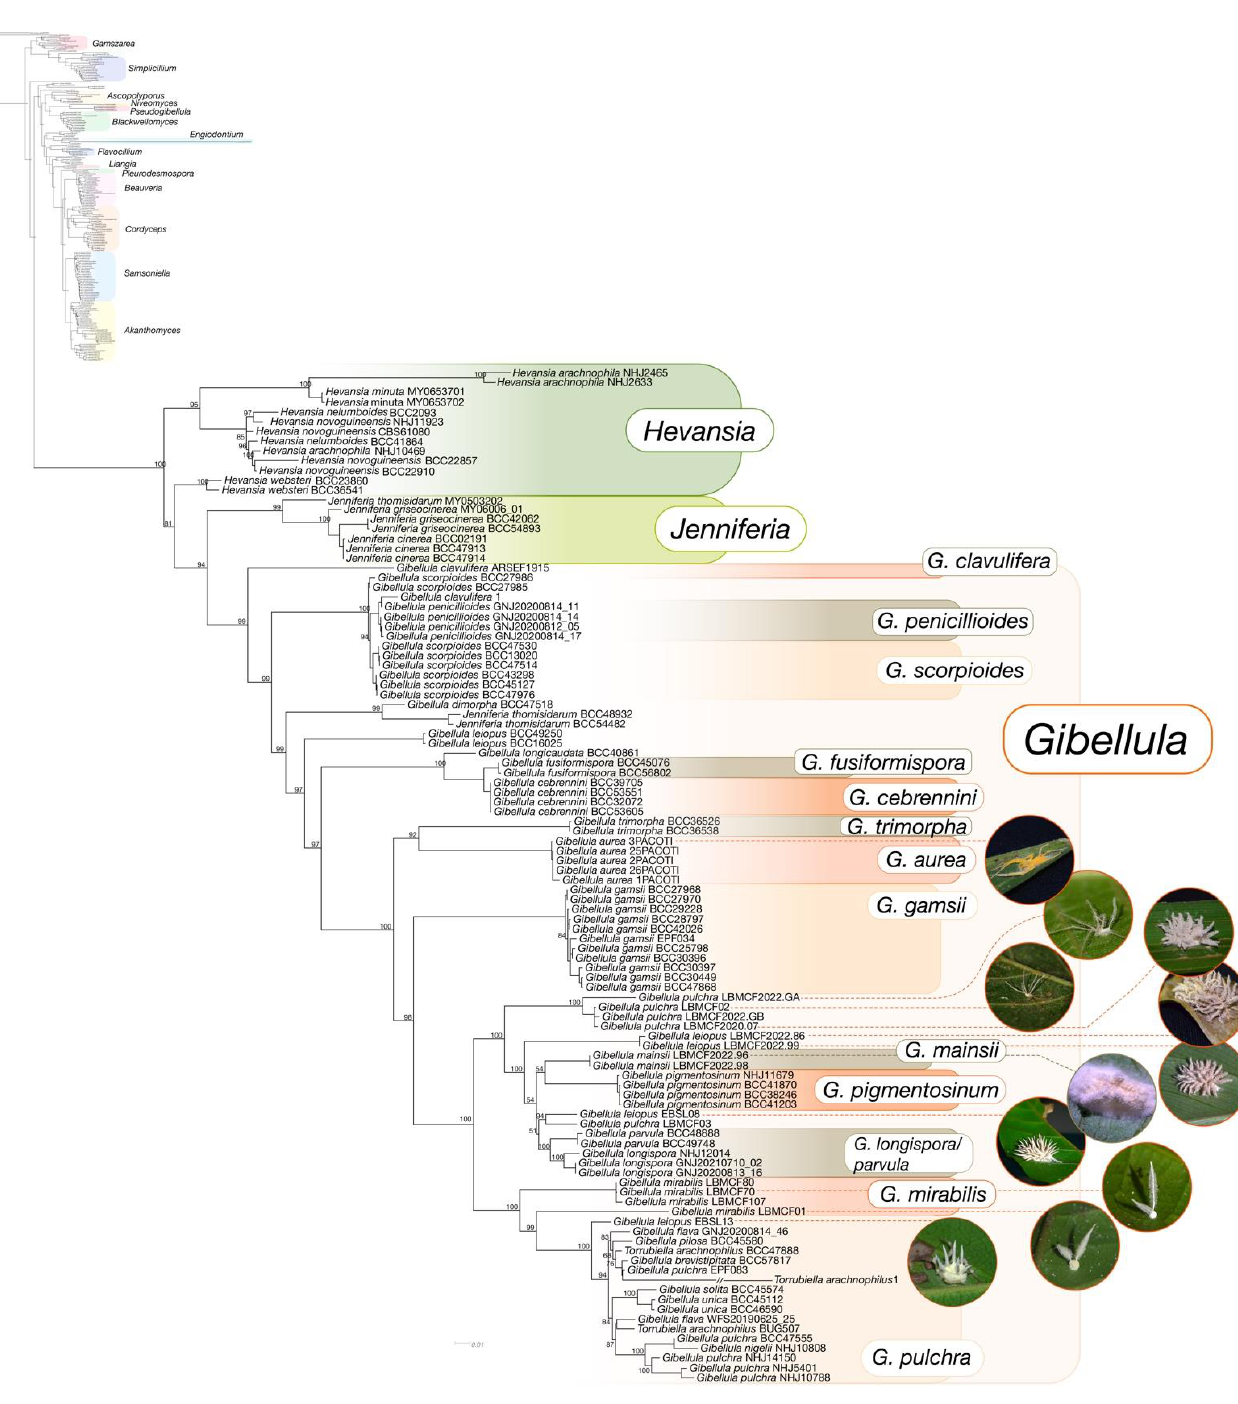
Figure 4. Phylogenetic tree using the Maximum Likelihood approach shows the specimens of Gibel- lula available at GenBank-NCBI databases, 14 fungal specimens collected at 4 Atlantic Rainforest sites in Brazil, and 21 genera of Cordycipitaceae, totalling 307 taxa. The analysis was based on con- catenated sequences of SSU, ITS, LSU, RPB1, RPB2, and TEF markers. Numerical values on branches indicate the percentages of bootstraps. Bars show nucleotide substitutions per